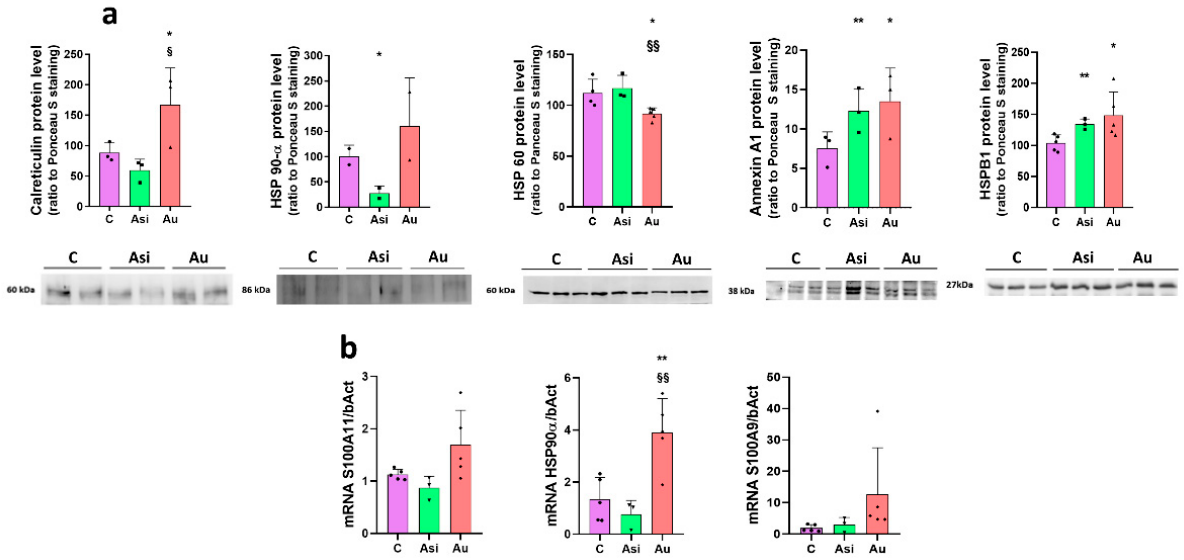
Figure 8. Verification and validation of mass spectrometry results through immune-based and gene expression assays. ( a ) Immunoblot experiments (lower panel) and the corresponding quantification histogram ( upper panel ) of control (C), PCSK9 siRNA-treated hyperlipidemic (Asi) and advanced hyperlipidemic (Au) samples, for calreticulin, HSP 90- α , HSP 60, Annexin A1, and HSPB1 proteins. The statistical significance over C samples is represented by * (* p < 0.05, ** p < 0.005), while the one over Asi is visible with § (§ p < 0.05, §§ p < 0.005). ( b ) Real-Time PCR relative quantitative analyses for S100A11, HSP 90- α , and S100A9 genes. The statistical significance over C samples is represented by * (** p < 0.005), while the one over Asi is visible with § (§§ p < 0.005). The scatter plot type histograms include biological values only.